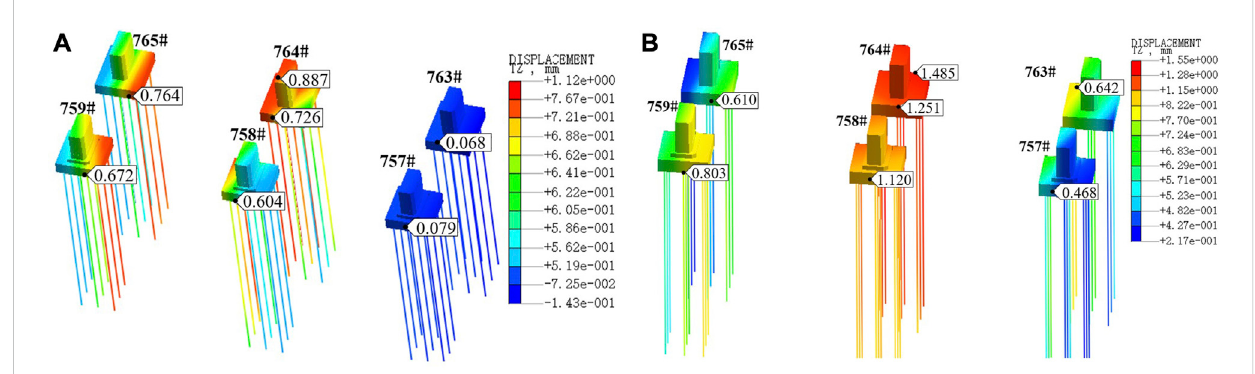
FIGURE 7 Vertical displacement of the piers (without isolation piles): (A) right line through and (B) left line